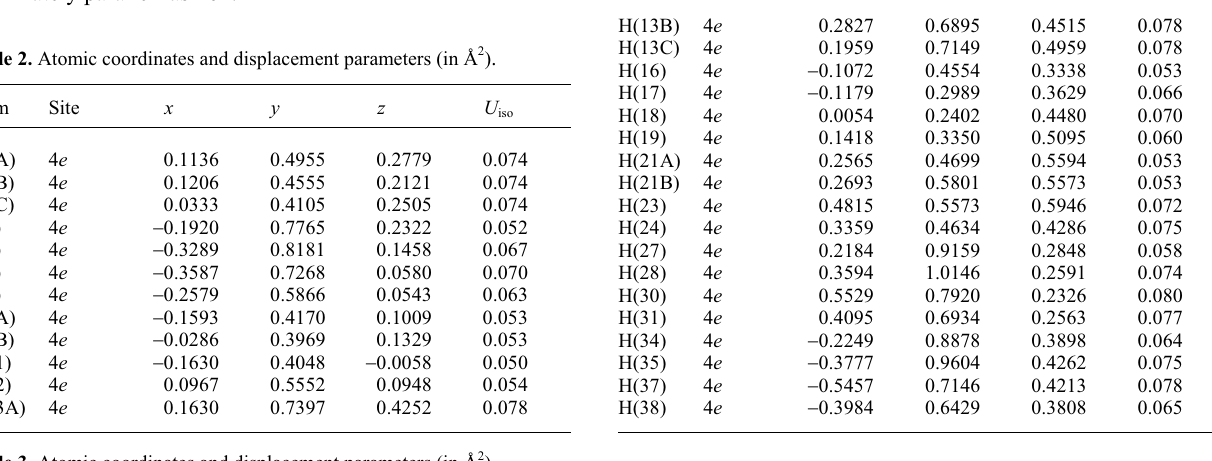
Table 3. Atomic coordinates and displacement parameters (in Å 2 )